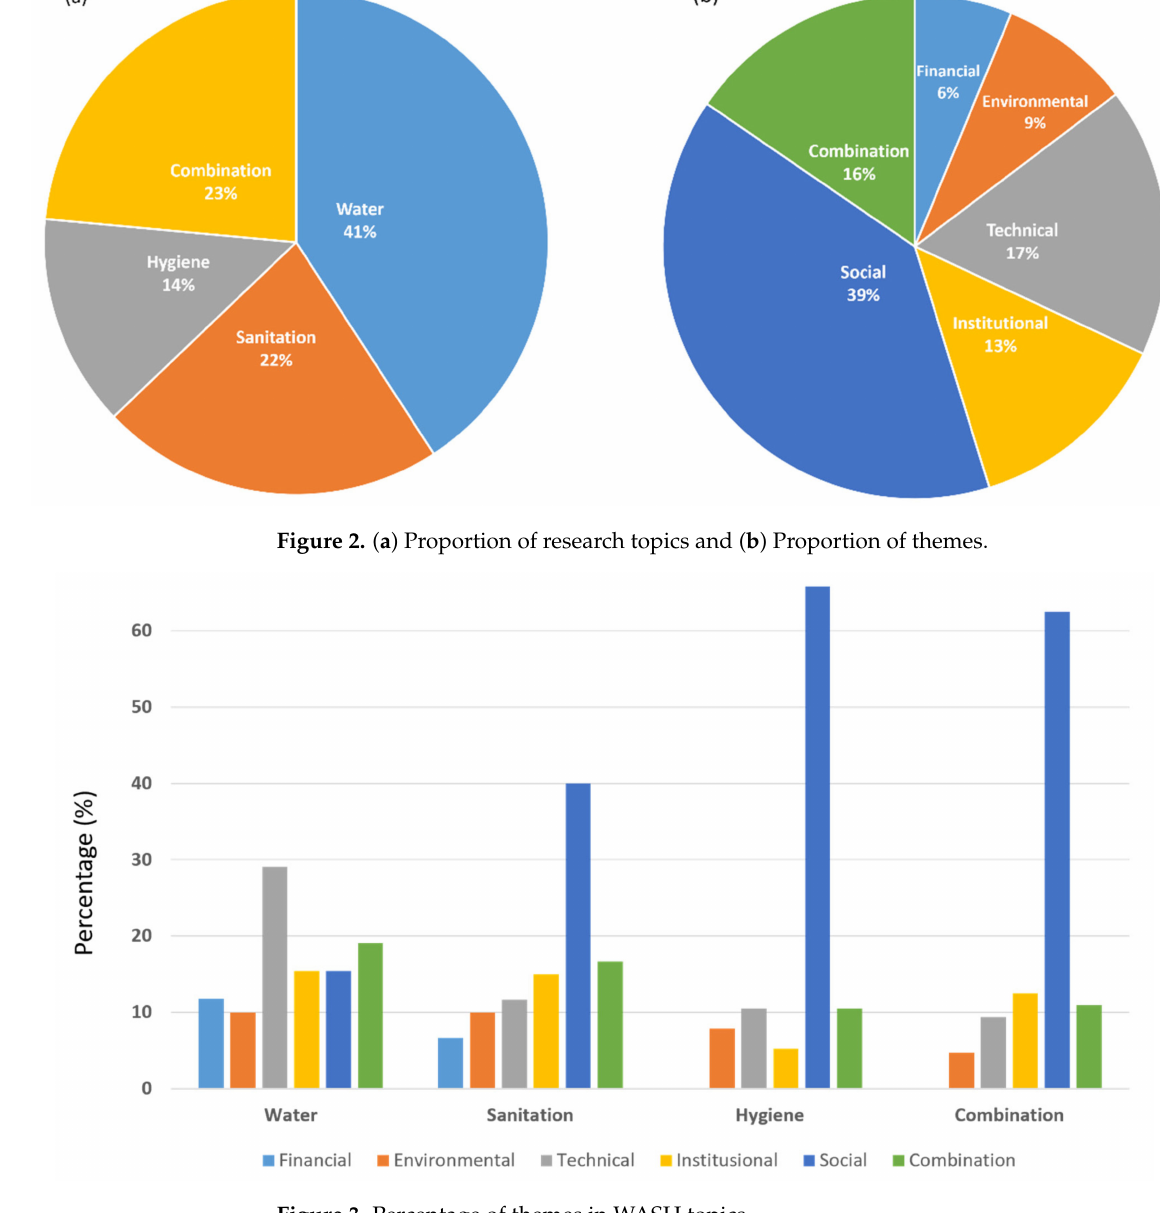
Figure 3. Percentage of themes in WASH